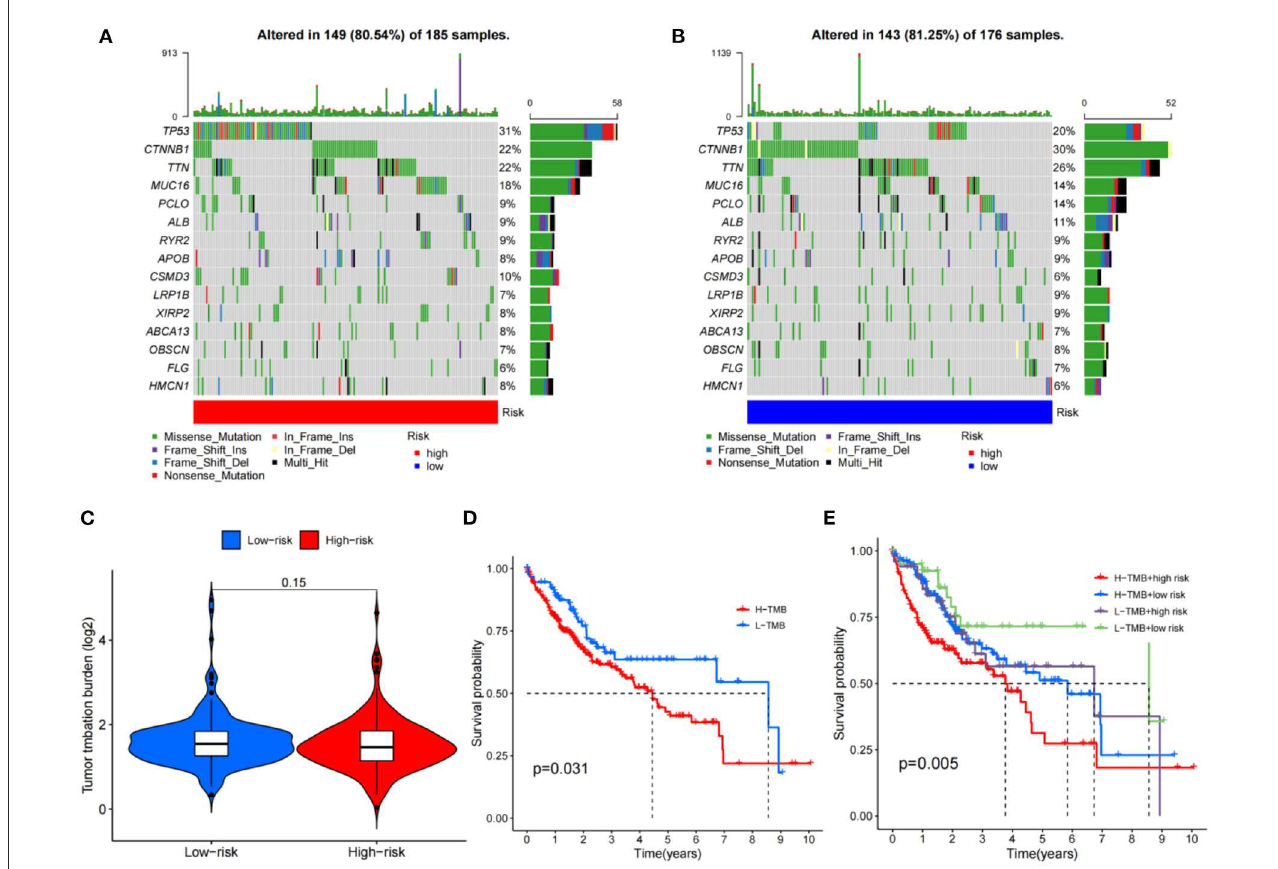
FIGURE10 TMB analysis; (A) The waterfall plot for the high risk group; (B) The waterfall plot for the low risk group; (C) The differential analysis of tumor mutation burden; (D) Survival analysis of tumor mutation burden; (E) Survival analysis of TMV + risk